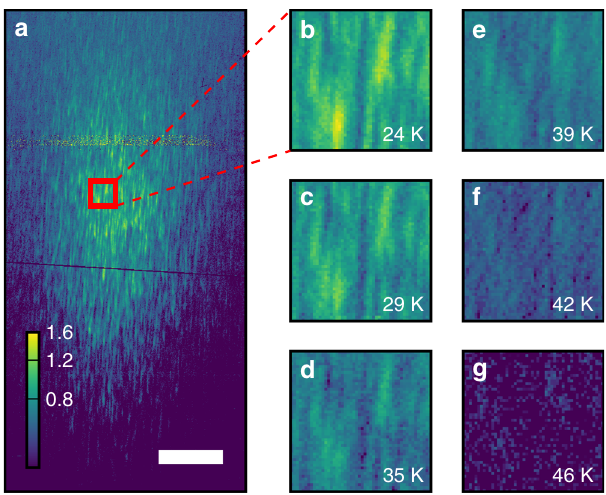
Fig. 2 Temperature dependence of the CDW speckle positions within the ordered state. a A detector image of the LBCO 1/8 CDW Bragg peak at 24 K at Q = (0.236, 0, 1.5). The color-bar denotes intensity in photons s − 1 , and the white bar at the bottom indicates 100 detector pixels (0.0025 r.l.u). b – g The temperature dependence of speckle positions as the temperature was raised from 24 to 46 K. Zoomed-in speckle images are taken from the same detector area indicated by the red box in ( a ). Despite the broadening and weakening of the CDW Bragg peak, the speckles tend to persist in similar locations to 46 K, above which the speckle intensity becomes too low and noise dominates the signal